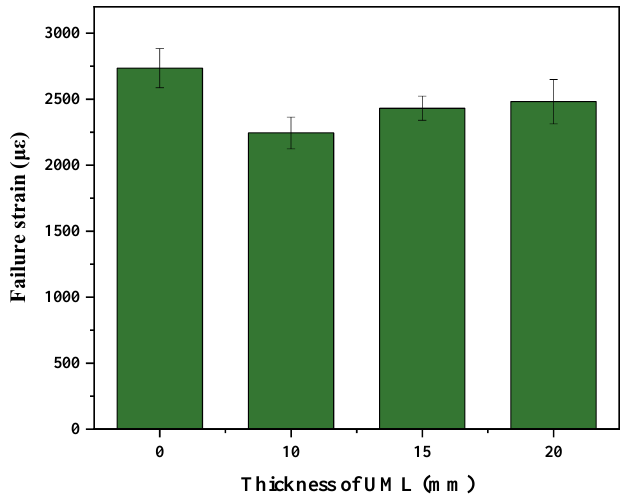
Figure 6. Failure strain of UMLs with different thicknesses.